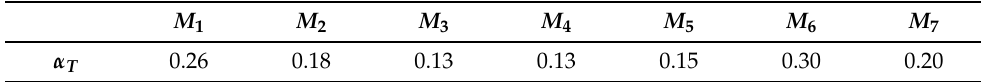
Table 3. Concentration thresholds α T computed for each model. The lowest and preferable values are obtained by the hybrid models M 3 , M 4 , and M 5 , indicating that they can discard more confidently false positive detections.